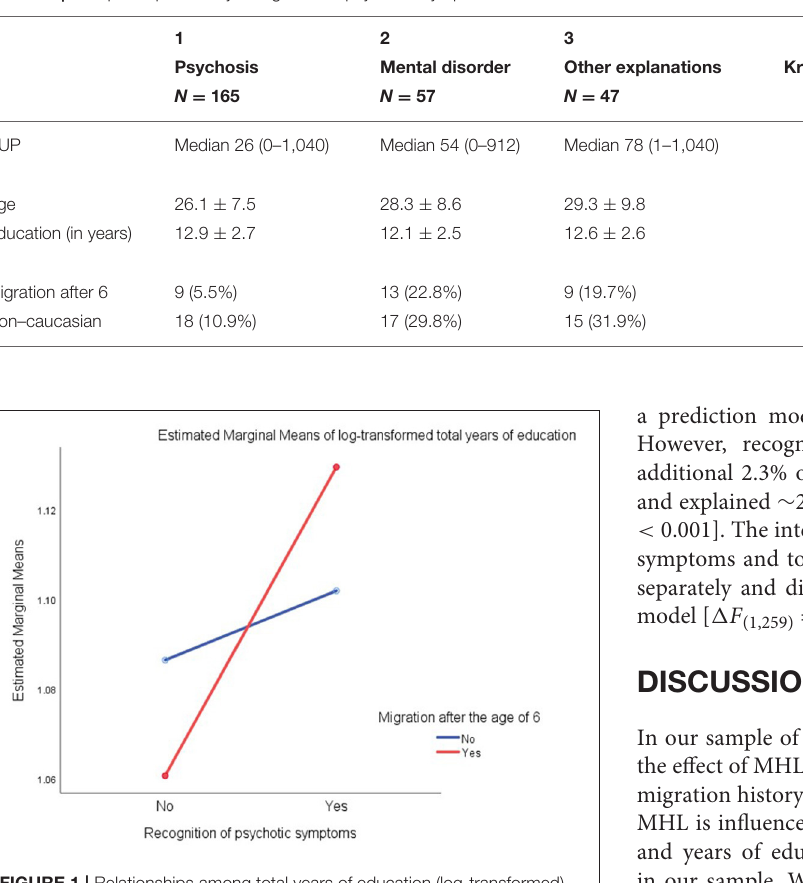
TABLE 4 | Group comparison by recognition of psychotic symptoms.